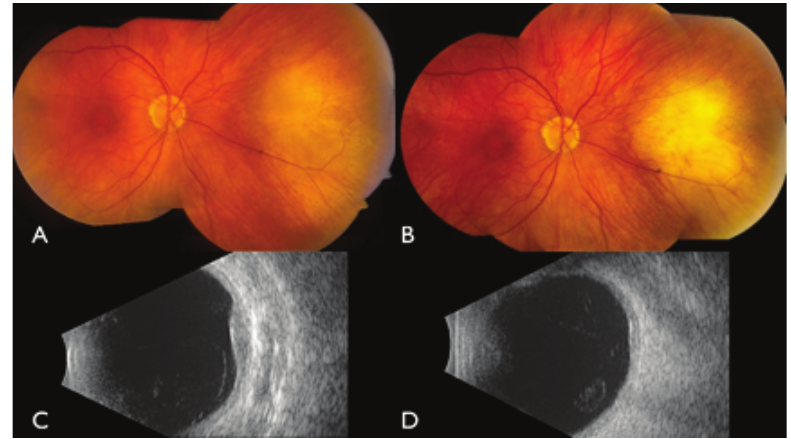
Figure 5. Fundus photograph of the right eye of a patient with amelanotic choroidal melanoma (A) before and (B) after PDT. PDT resulted in the regression of the tumor confirmed with B-scan ultrasonography (C,